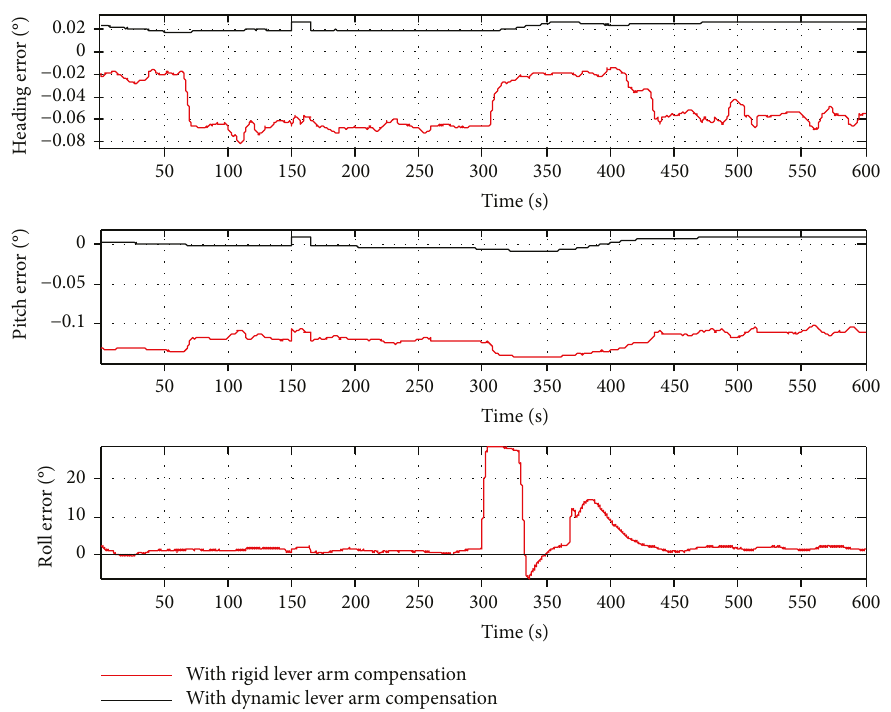
Figure 13: Attitude error comparison of the second-level dynamic lever arm error